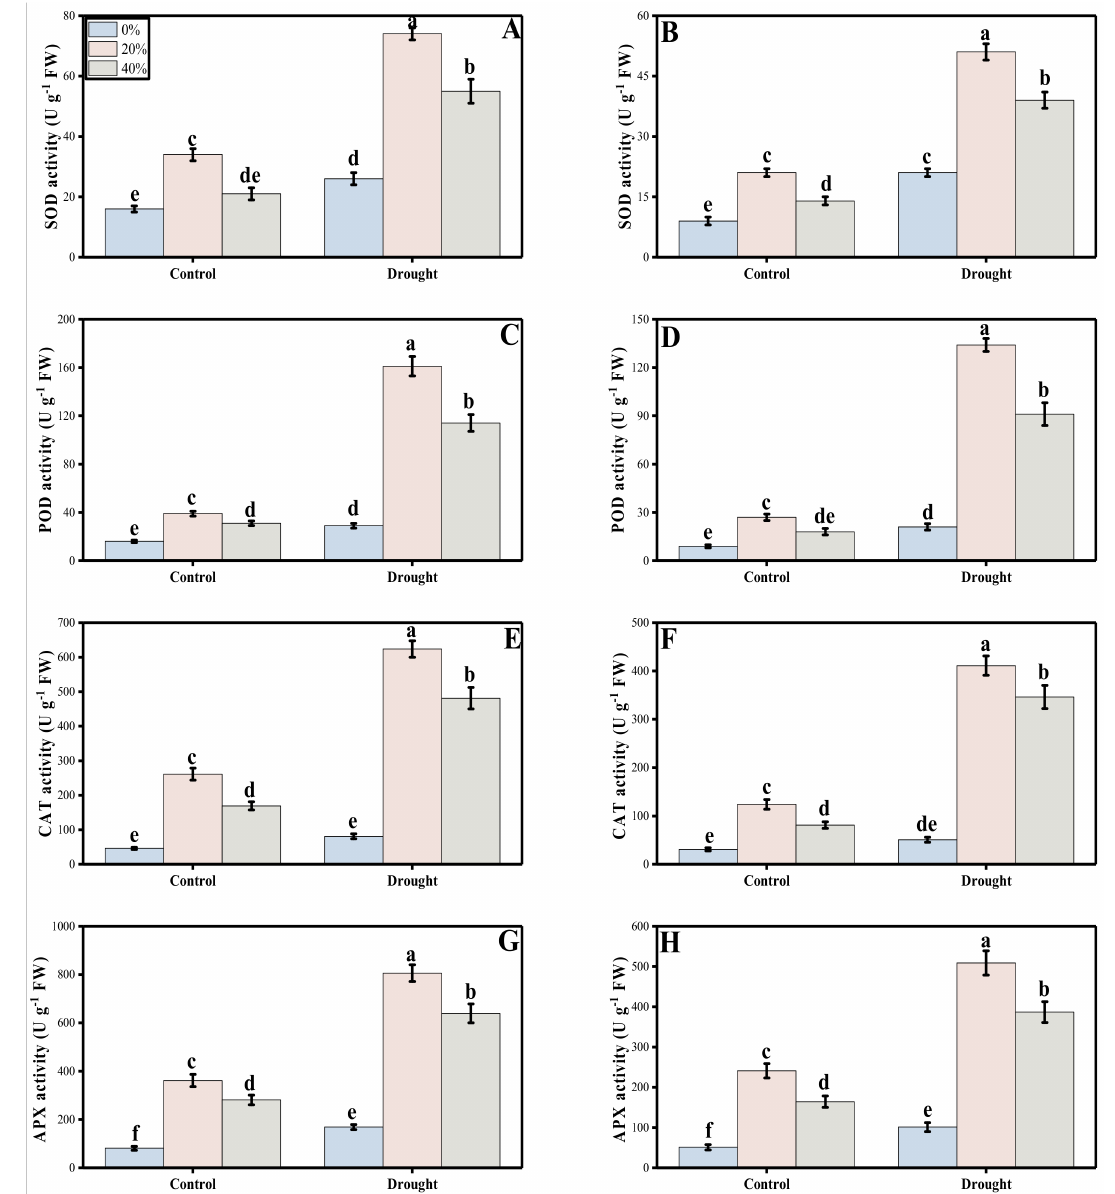
Figure 6. Effect of seed priming with Plantago ovata leaf extract on SOD activity in the roots ( A ), SOD activity in the leaves ( B ), POD activity in the roots ( C ), POD activity in the leaves ( D ) CAT activity in the roots ( E ), CAT activity in the leaves ( F ), APX activity in the roots ( G ) and APX activity in the leaves ( H ) under water stressed and non-stressed environments in maize cultivar Cimmyt − Pak. Means sharing similar letter(s) within a column for each parameter do not differ significantly at p < 0.05. Data in the figures are means of three repeats ( n = 3) of just one harvest of Zea mays plants ± standard deviation (SD). Different lowercase letters on the error bars indicate significant difference between the treatments. Different treatments ( P. ovata extract) used in this study are as follows: 0% (0% P. ovata extract), 20% (20% P. ovata extract) and 40% (40% P. ovata